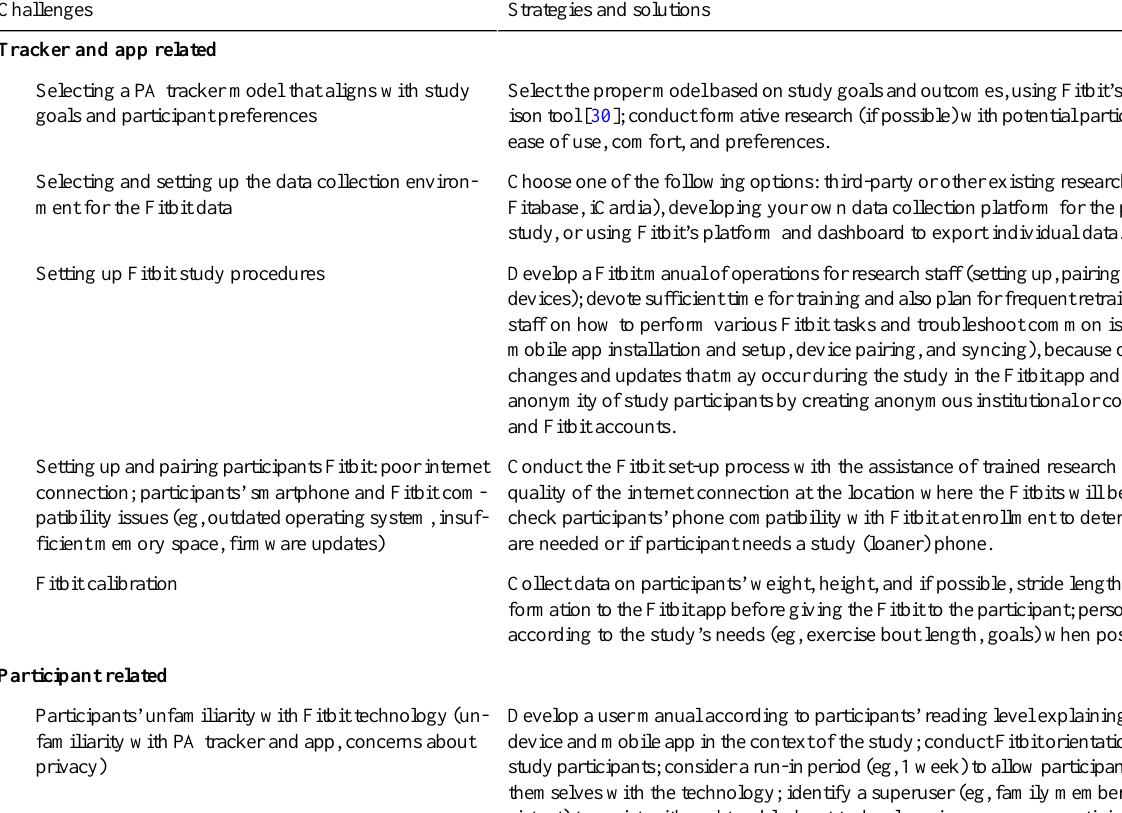
Table 2. Challenges and solutions or strategies for utilizing the Fitbit physical activity (PA) tracker in health interventions at the study preparation